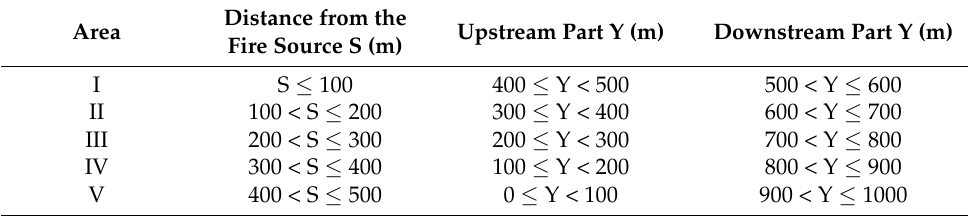
Table 9. Area-dividing